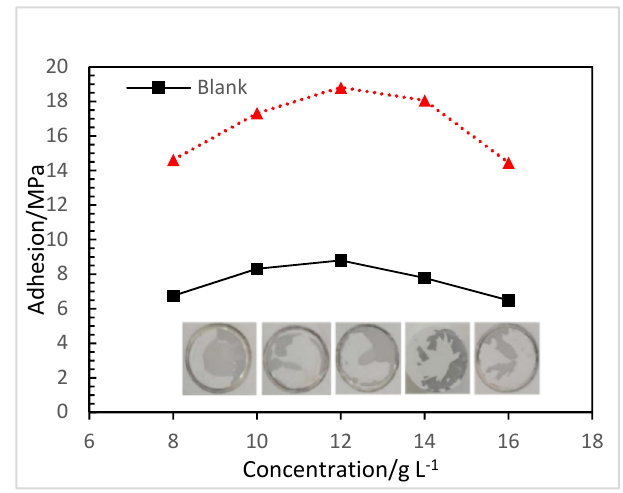
Figure 6. Adhesion strength between modified and unmodified MAO samples.